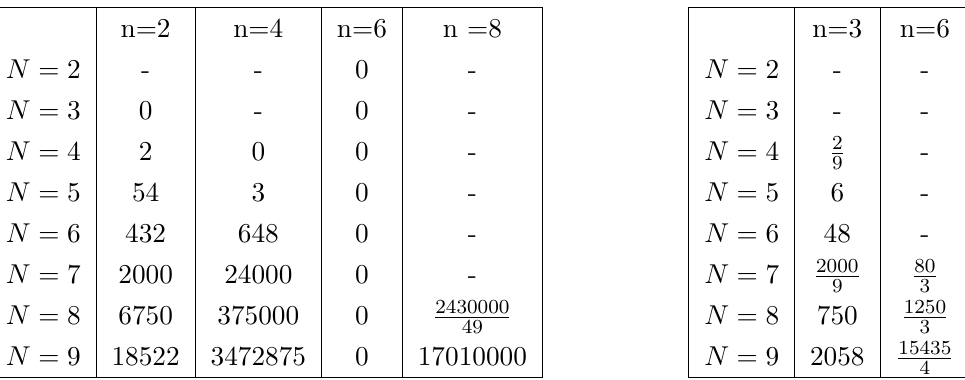
i , with n = 3 k [ k 3 ] ; [ k 3 ] ; [ k 3 ]